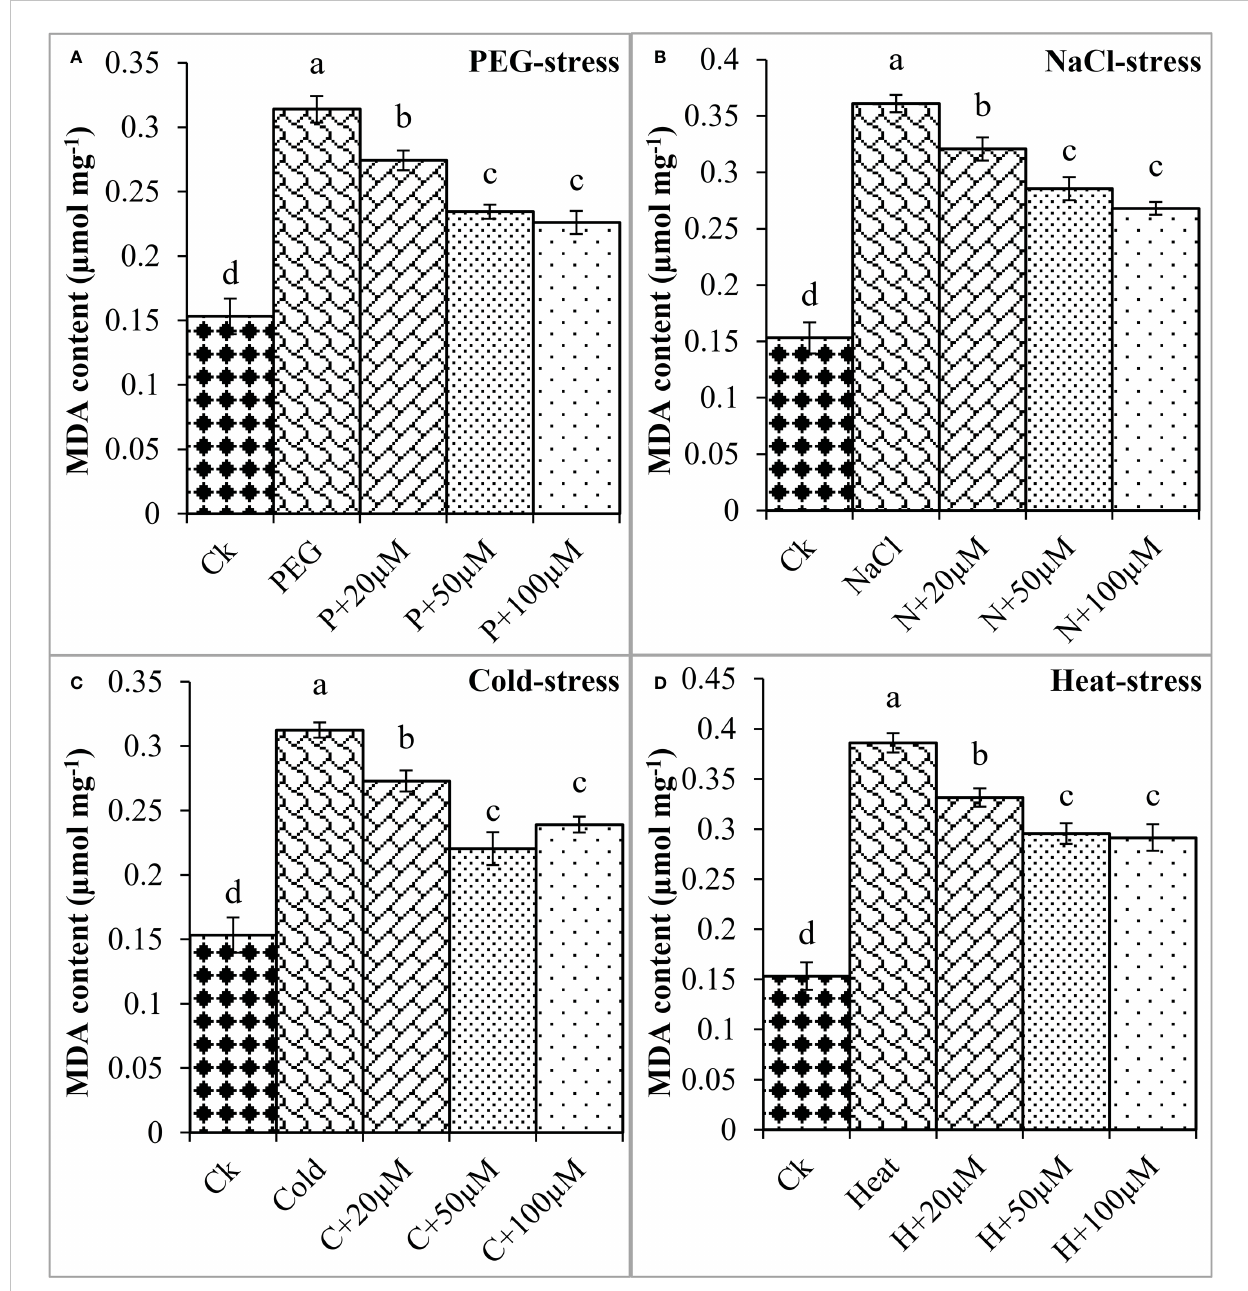
FIGURE 4 Effect of different concentrations of melatonin on the activity of MDA content under PEG (A) , NaCl (B) , Cold (C) , and Heat (D) . Values are the means ± SD (n=3). Different letters on the bars show a statistical signi fi cance level at p<0.05 . Here, µM is indicating (µmole L -1